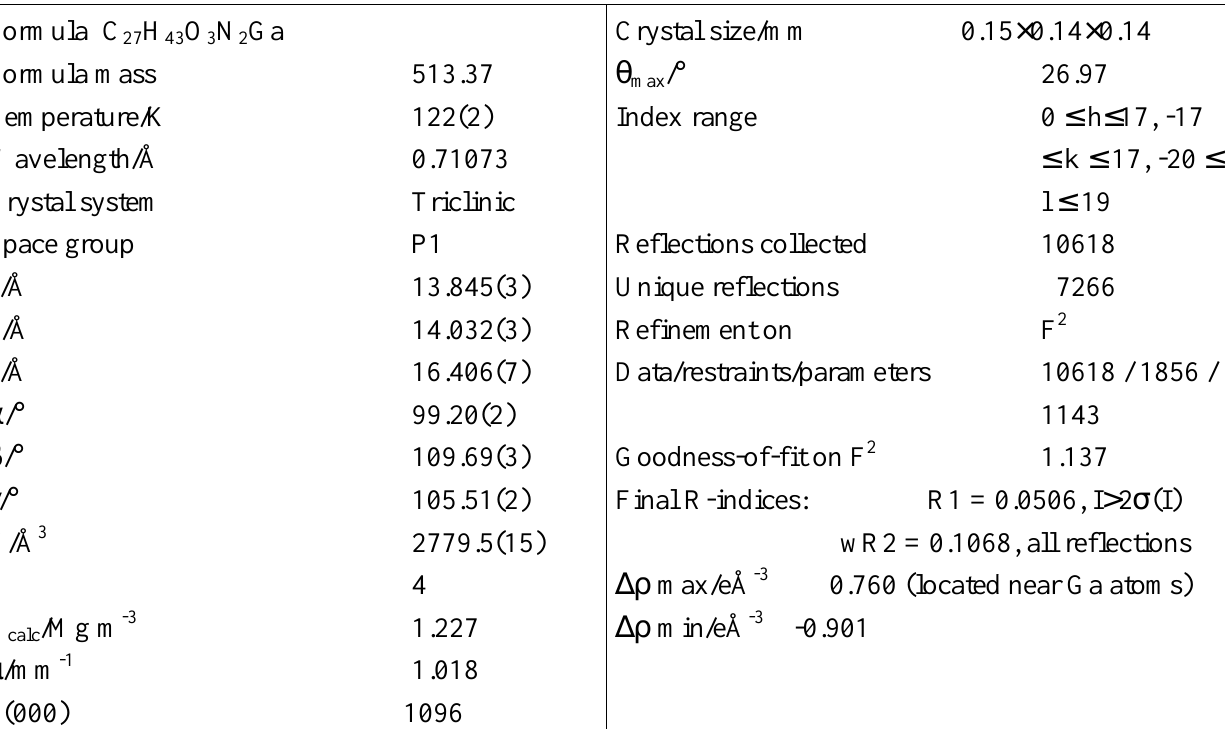
Table 4 . Crystal data and structure refinement for the